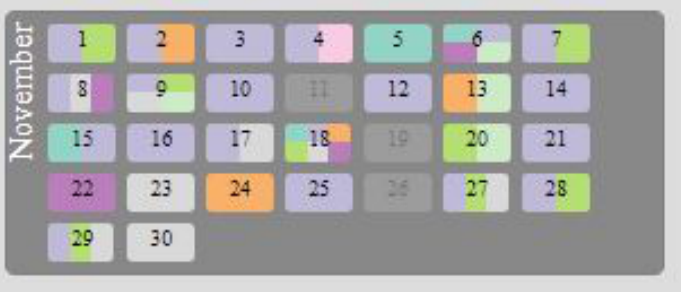
Figure 11. Overview of written texts of November 1944, after adding tents and storm to the